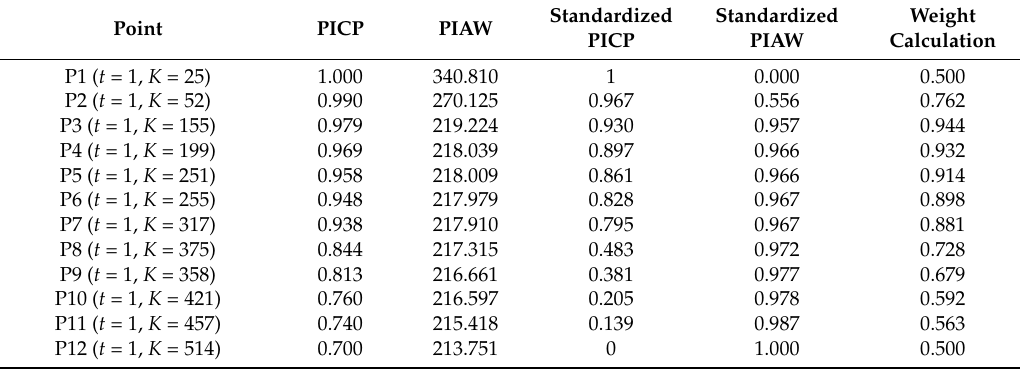
Table 1. Weight calculation results of the points in the Pareto optimal solutions set in region 1.